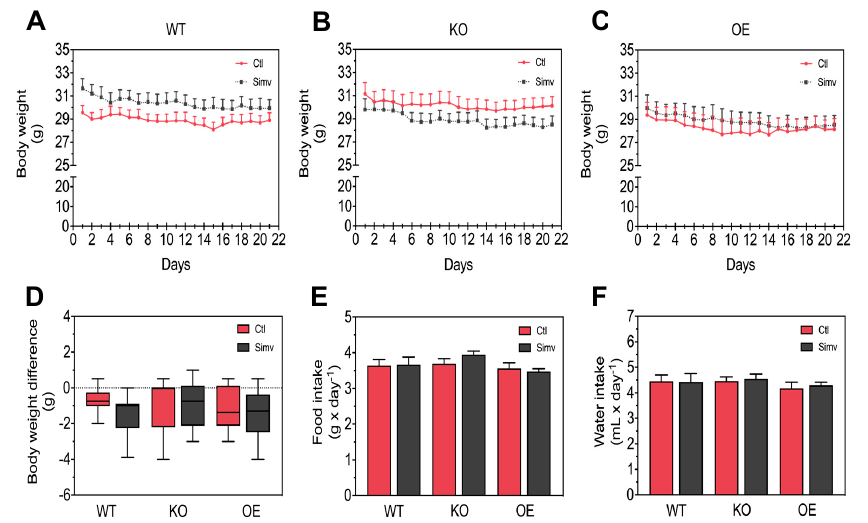
Figure 1. General physiological parameters. Physiological parameters, such as body weight, water and food intake, were monitored daily during the treatment. Body weight is shown as the average during the three weeks of treatment for WT mice ( A ), KO mice ( B ), and for OE mice ( C ). The change in body weight is shown as a difference in grams between the body weight at the end and at the start of treatment ( D ). Food ( E ) and water ( F ) intake are presented as an average value during the treatment. Data are presented as mean ± SEM of 10 animals per group. There were no statistically significant differences between the groups and for treatment with simvastatin. Ctl, control; KO, PGC- α knock-out mice; OE, PGC-1 α overexpressing mice; Simv, simvastatin; WT, wild-type.